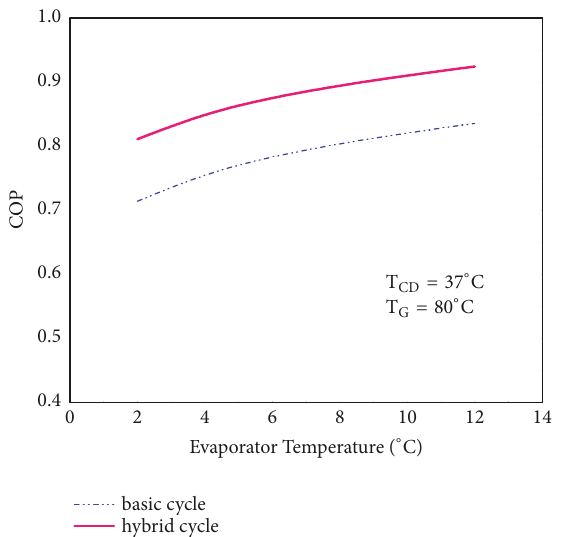
Figure 10: 𝐶𝑂𝑃 ℎ𝑦𝑏𝑟𝑖𝑑 vs . 𝑇 𝐺 for varying condenser temperature, 𝑇 𝐶𝐷 .